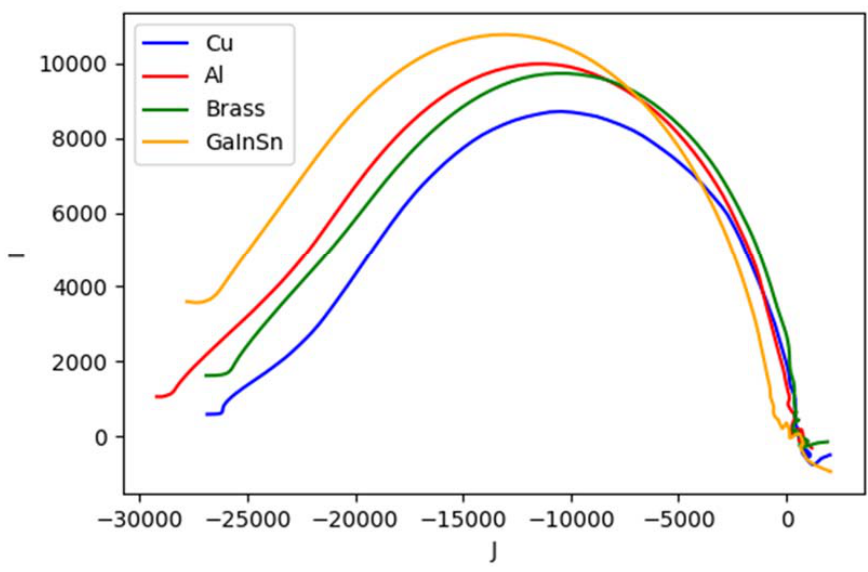
Figure 23. Complex plot of impedance for metallic samples with conductivity variations.